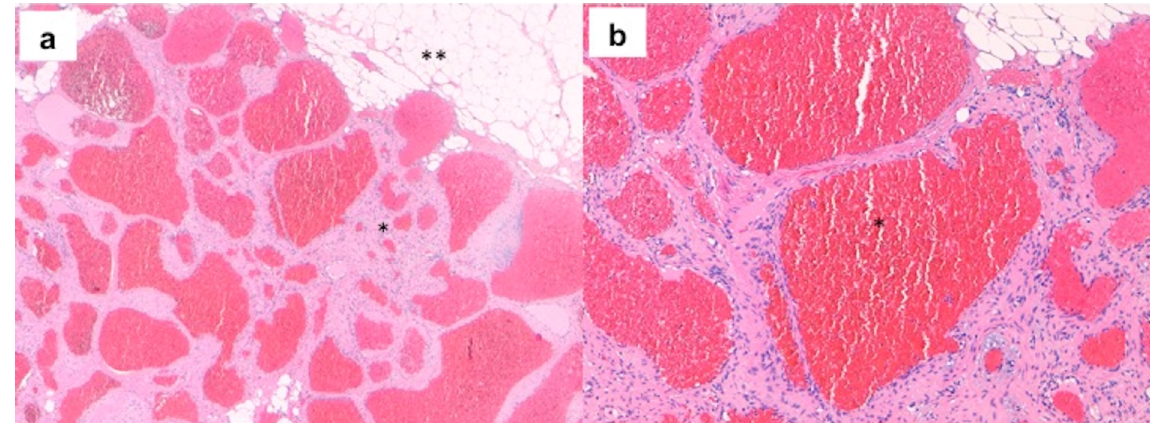
Figure 2: a) Fibrous benign stroma (*) with dilated cavernous vessels and mature adipocyte cells in the periphery (**), H&E x4. b) The vessels filled with red blood cells (*). The endothelium and the stroma showed no signs of malignancy, H&E